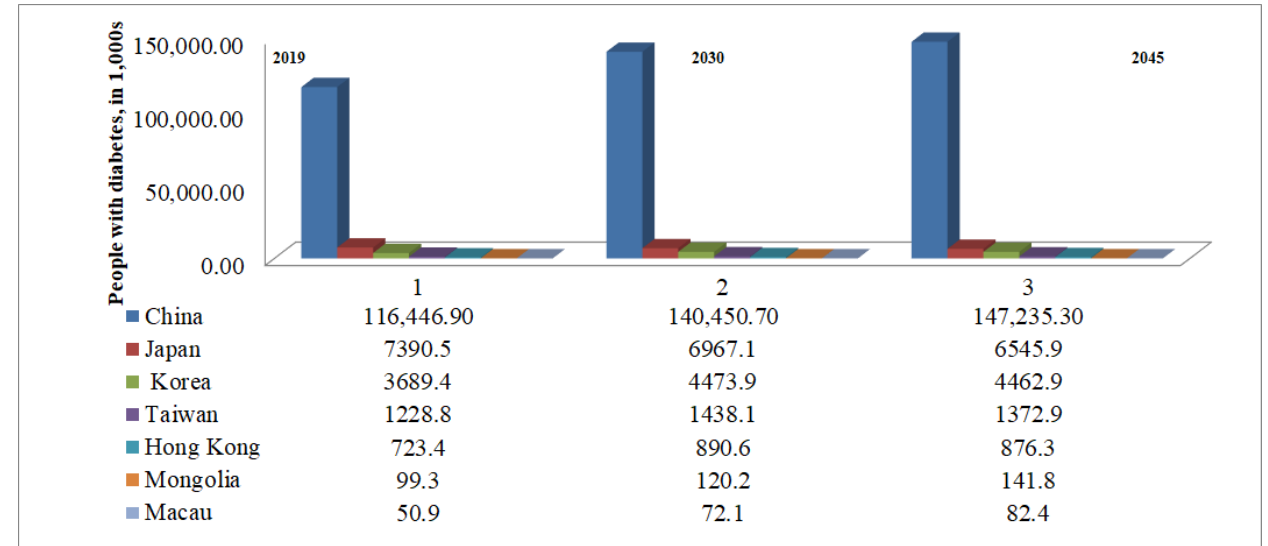
Figure 1. Comparison of information about diabetes between East Asian countries.